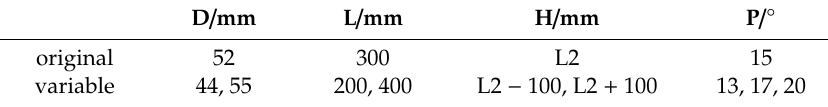
Figure 3. The grid of V-shaped support with di ff erent parameters (the straight-section diameter D = 44 mm / 52 mm / 55 mm, the straight-section length L = 200 mm / 300 mm / 400 mm, the first-section length H = L2 – 100 mm / L2 / L2 + 100 mm, the inflection angle P = 13 ◦ / 15 ◦ / 17 ◦ / 20 ◦ , and multiple variable parameters L = 400 mm / H = L2 + 100 mm). Table 2. Di ff erent geometric parameters of the V-shaped